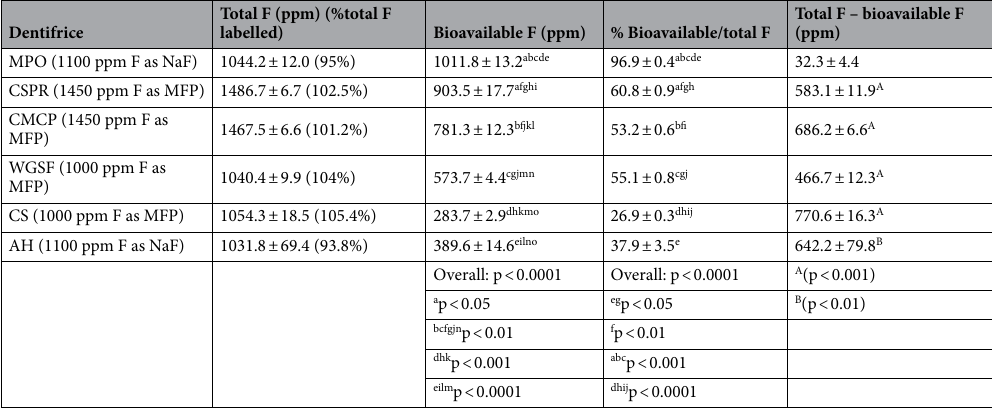
Table 2. Measured total and bioavailable fluoride levels in six calcium-containing dentifrices. Values with the same lowercase superscript in columns are significantly different. Values with an uppercase superscript indicate the dentifrice had significantly lower bioavailable F compared with total